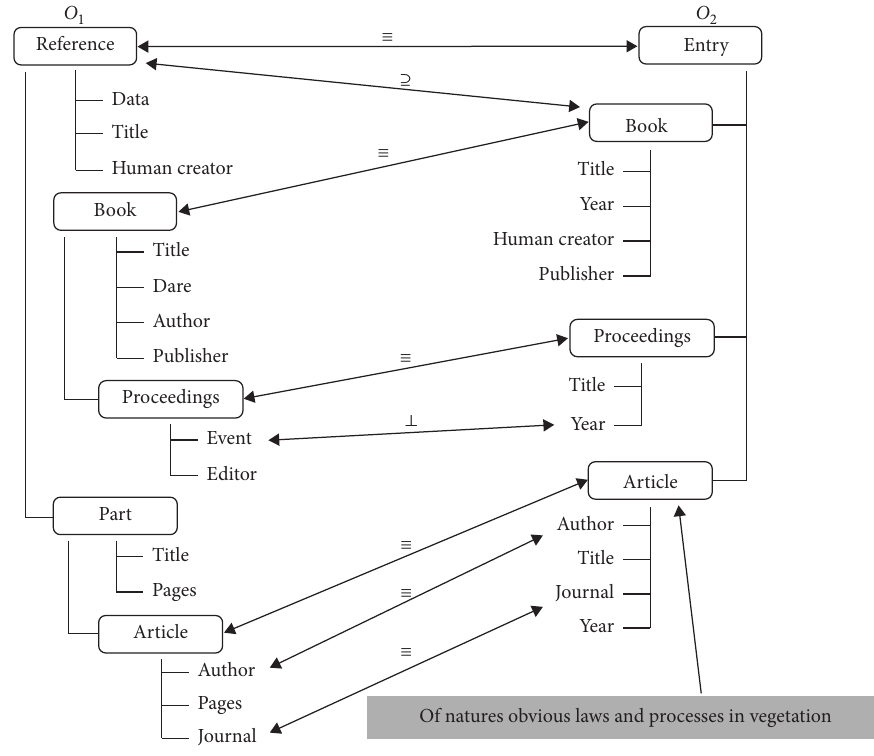
Figure 2: An example of matching two ontologies.